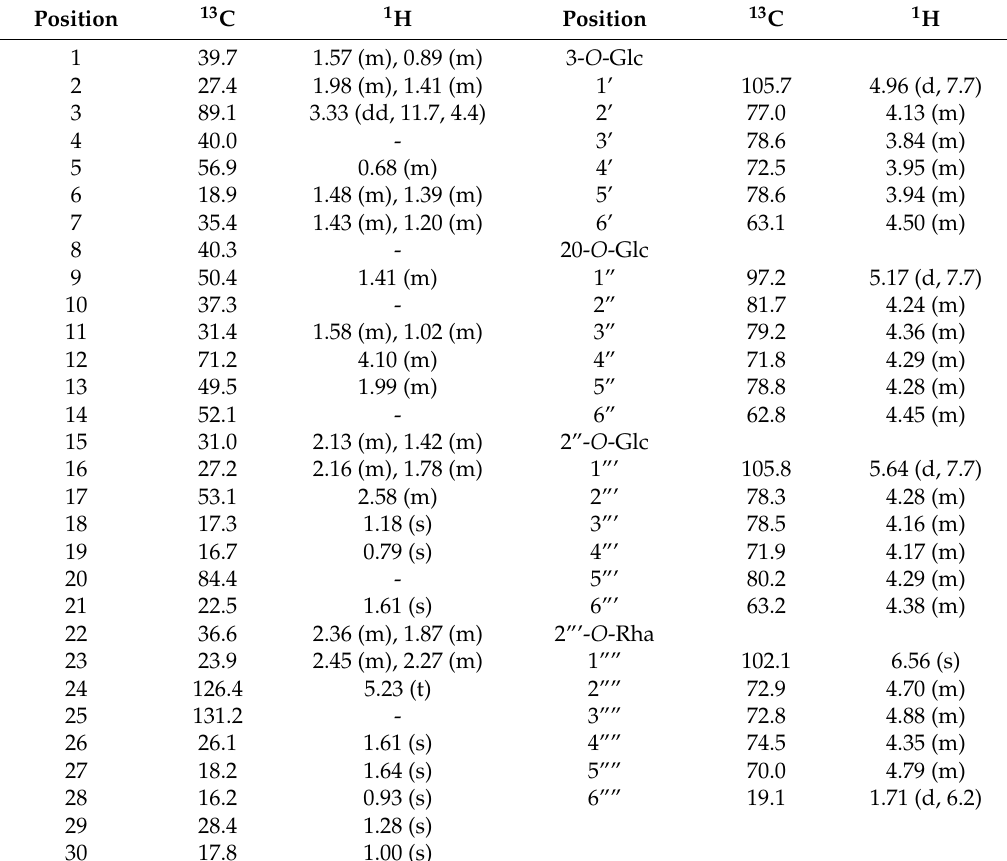
Table 4. 1 H NMR and 13 C-NMR spectral data of compound 8 (600 MHz and 150 MHz, pyridine- d 5 , δ in ppm, J in